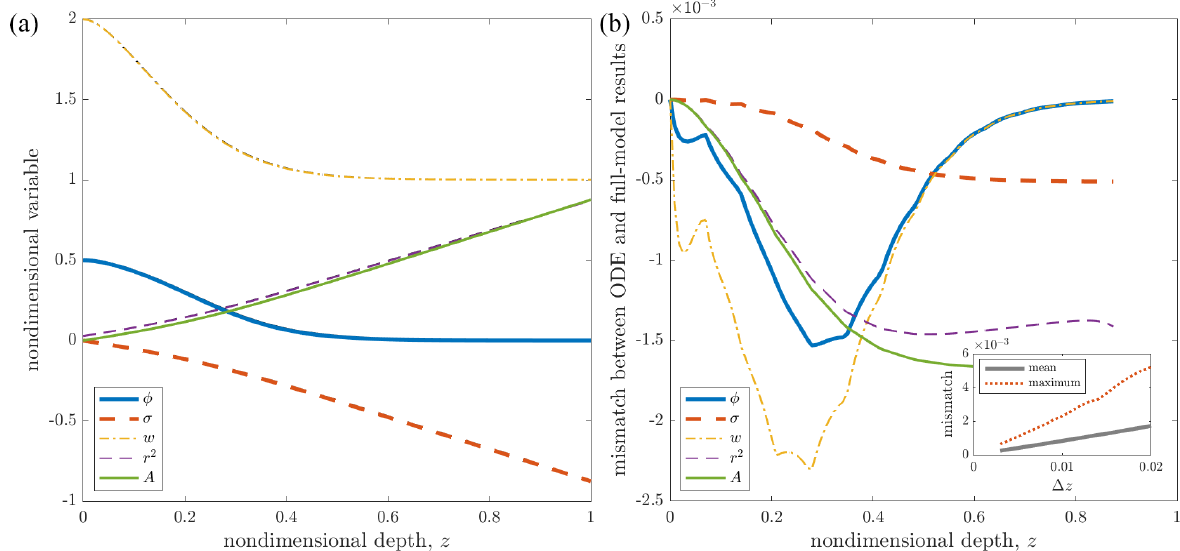
Figure 2. (a) A solution to the reduced ODE model overlaid on a steady-state solution to the full compaction model. Both simulations use (cid:49)z = 10 − 2 m 2 , and n = m = 1, which yields α = 0.082 and δ = 0 . 088. = 0.01, r 2 s = 0.029, b 0 = 0 . 1ma − 1 , β = 1, φ s = 0.5, T s = 253 . 15K, r 2 f The two sets of curves are indistinguishable at the scale of the plot. (b) Mismatch between each variable computed with each model, as functions of z . Inset shows the mean and maximum mismatch (over all z and all five variables) as functions of (cid:49)z